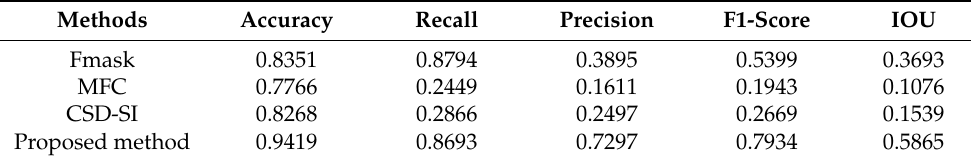
Table 4. Comparison of feature-based cloud detection methods quantitative accuracy.